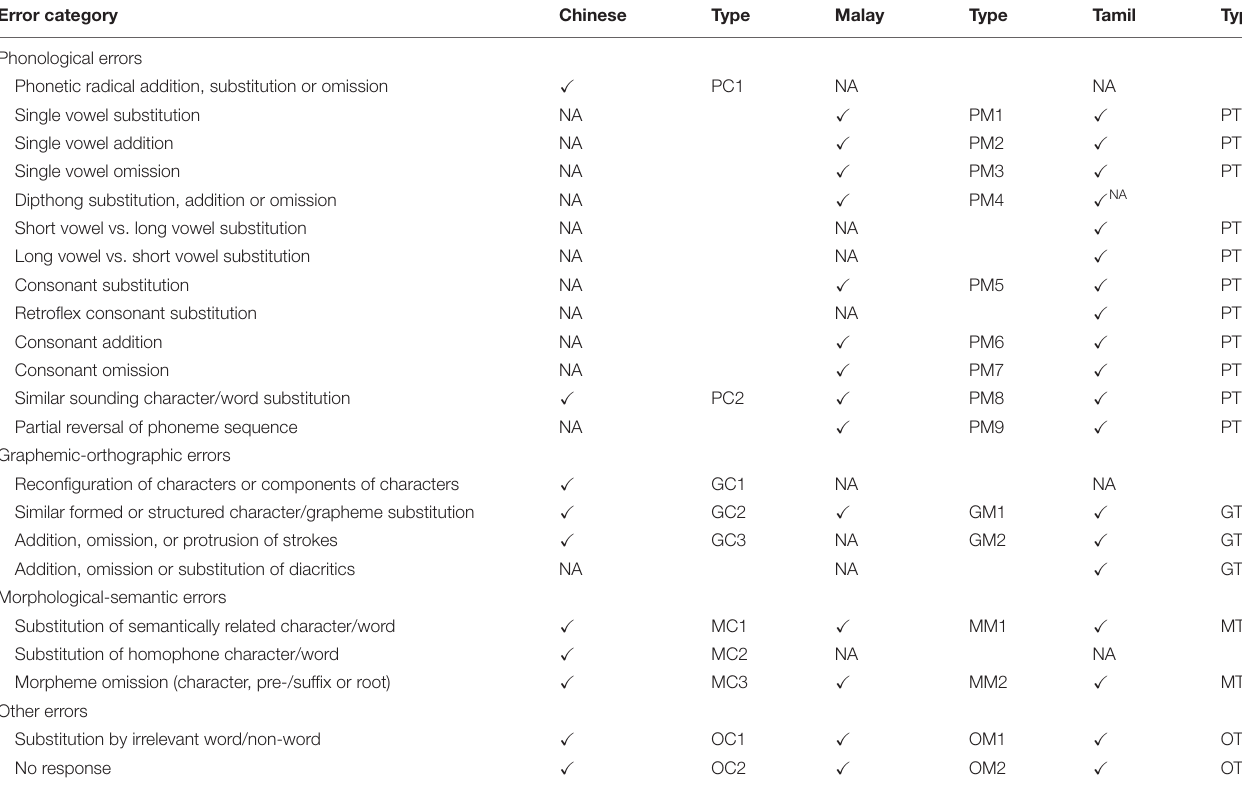
TABLE 4 | Overview of Asian language spelling error coding